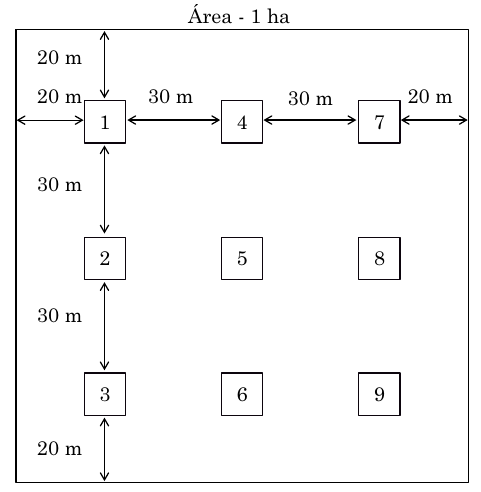
Figura 1. Representação esquemática da coleta de amostras para determinar os atributos do